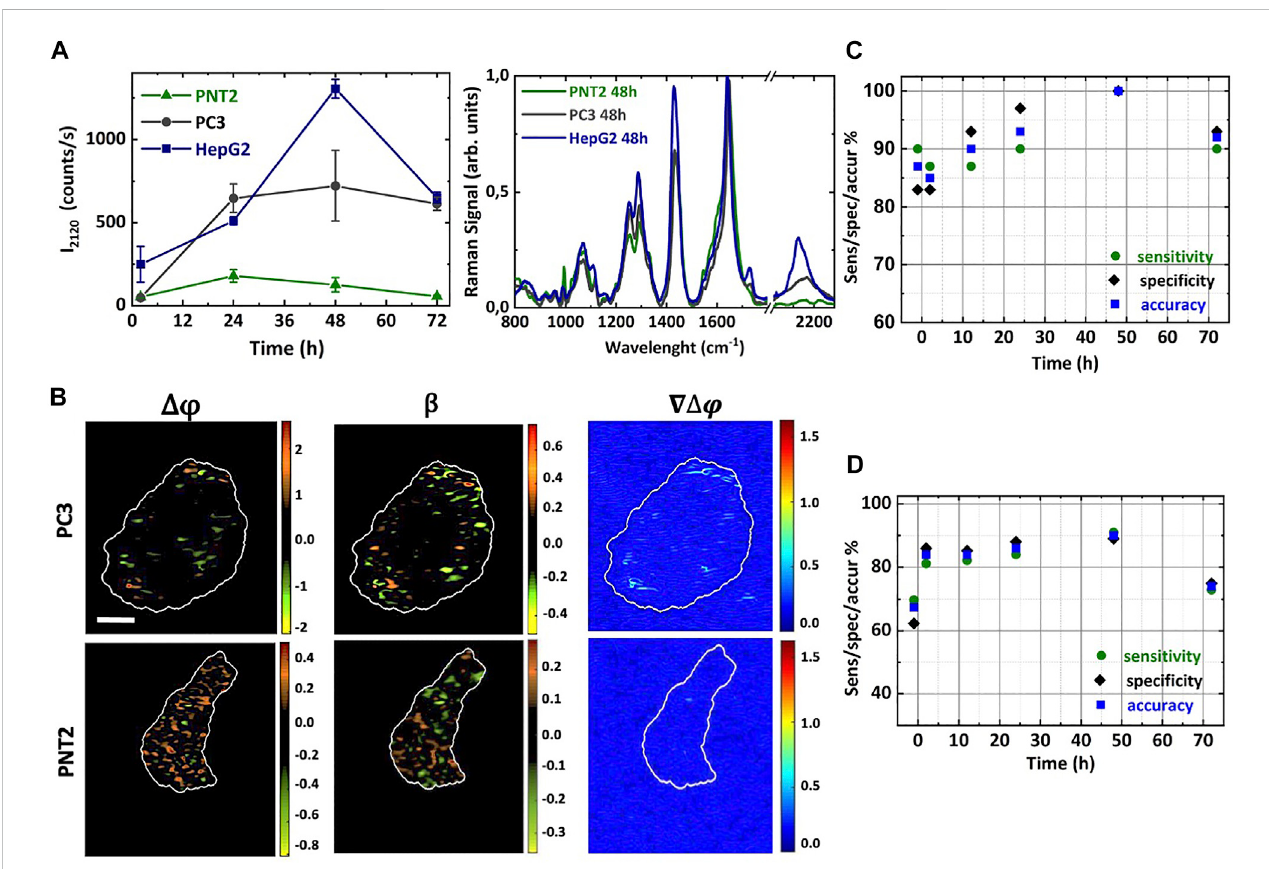
FIGURE 3 Deut-Glc uptakedynamics in cancer and non-cancer cells. (A) Intensity of the C-D Ramanbands for normalPNT2 (green triangle) cells, and cancer PC3 (grey circle) and HepG2 (blue square) cells treated with 25 mM deut-Glc for 2, 12, 24, 48 and 72 h. The corresponding mean Raman spectra of PNT2 (green line), PC3 (grey line) and HepG2 (blue line) cells treated with 25 mM deut-Glc for 48 h are additionally shown. (B) Phase difference Δϕ , amplitude ratio β and gradient of the phase difference maps ∇ Δϕ for cancer PC3 and non-cancer PNT2 cell lines treated with deut-Glc for 48 h. Scale bar: 5 μ m. PCA analysis comparing PNT2 and PC3 cell lines. Trend of the sensitivity (green circles), speci fi city (purple diamonds) and accuracy (blue square) obtained at different glucose incubation times for the Raman data (C) and PSDHI data sets (D)